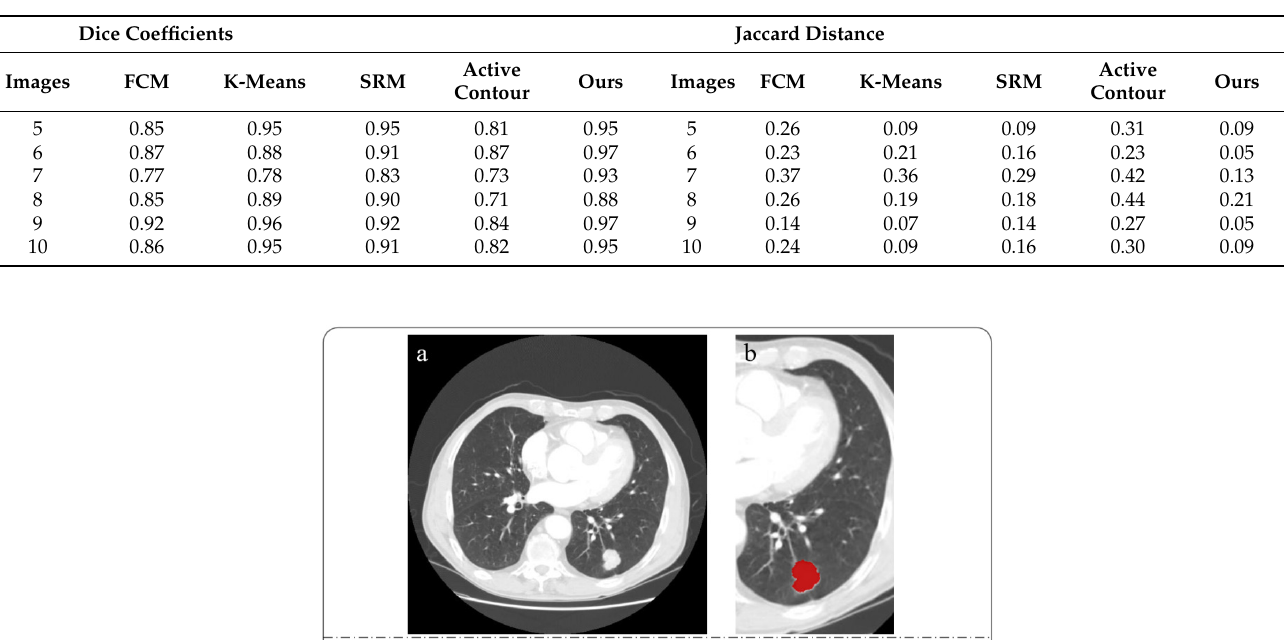
Table 2. In the LIDC-IDRI dataset, the dice coefficients and Jaccard distance obtained by different methods are statistically compared.